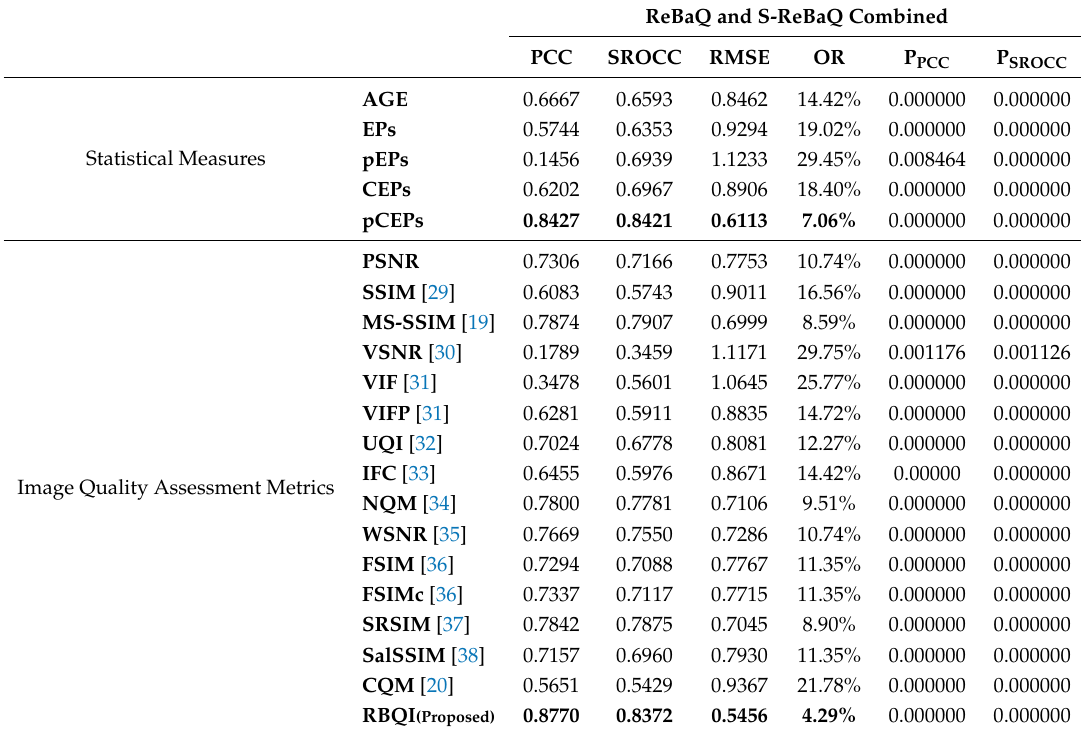
Table 3. Comparison of RBQI vs. Statistical measures and IQA techniques on a combined ReBaQ and S-ReBaQ